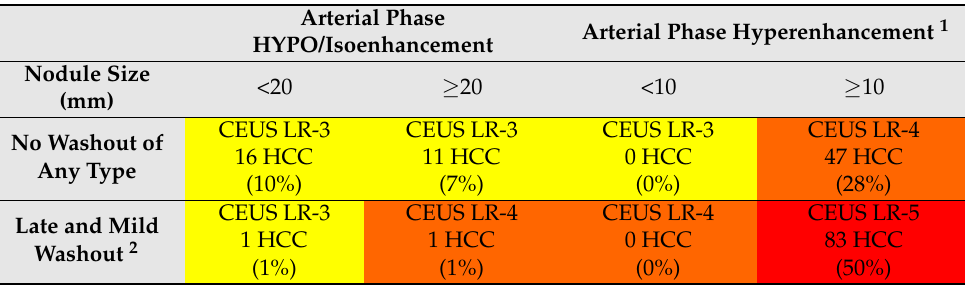
Table 2. CEUS LI-RADS subcategories and relative